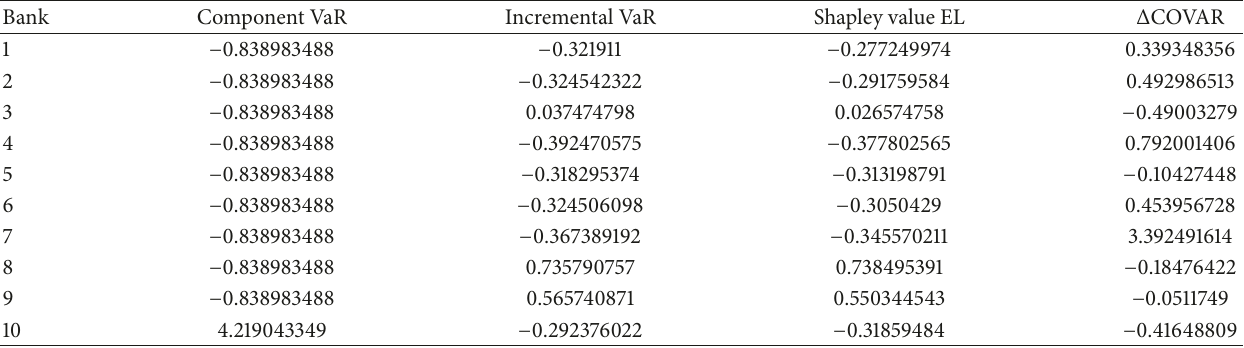
Table 2: Increase in capital as a share of banks’ risk weighted assets for macroprudential capital allocation mechanisms in 2009. Bank Component